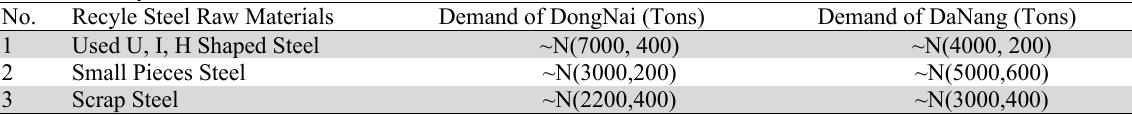
Demand of Recycle Steel Raw